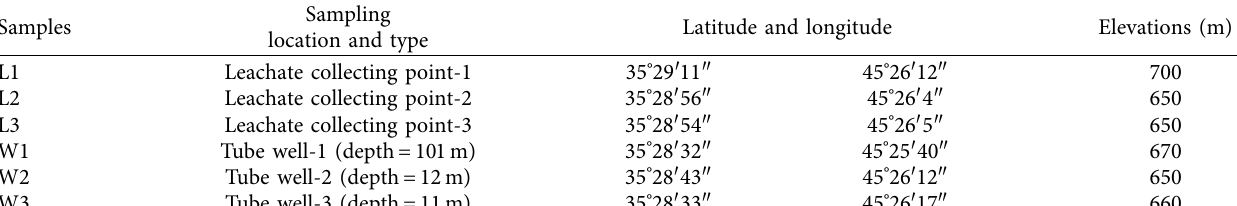
Table 1: Site specifcation for sampling.